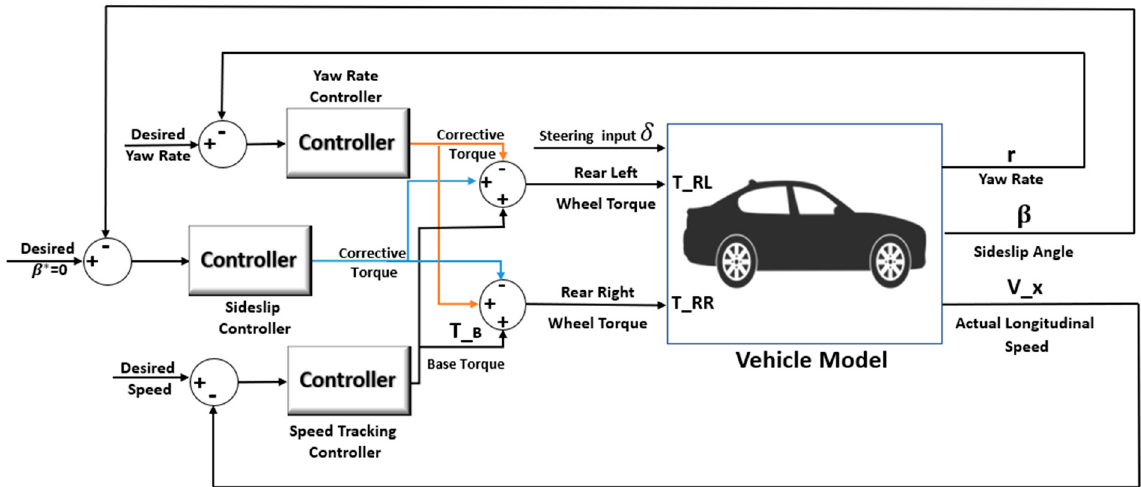
Figure 3. The Closed Loop DYC Control System.